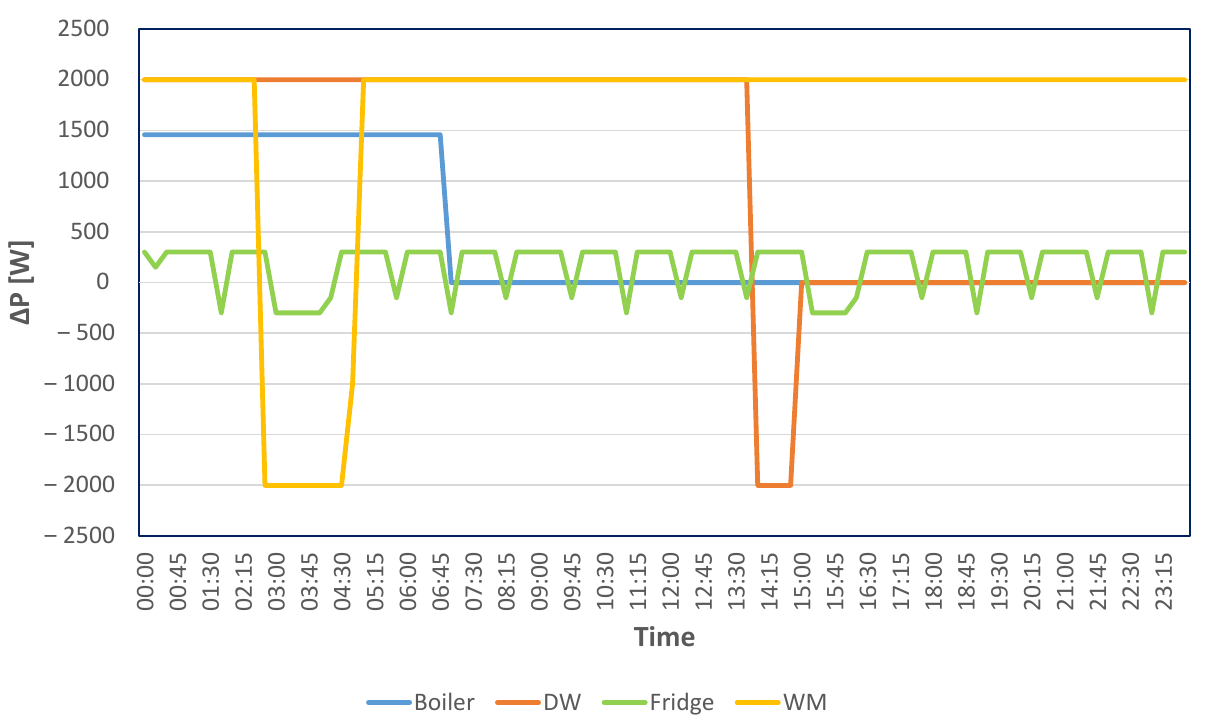
Figure 12. Updated flexibility diagrams after the first DR action.